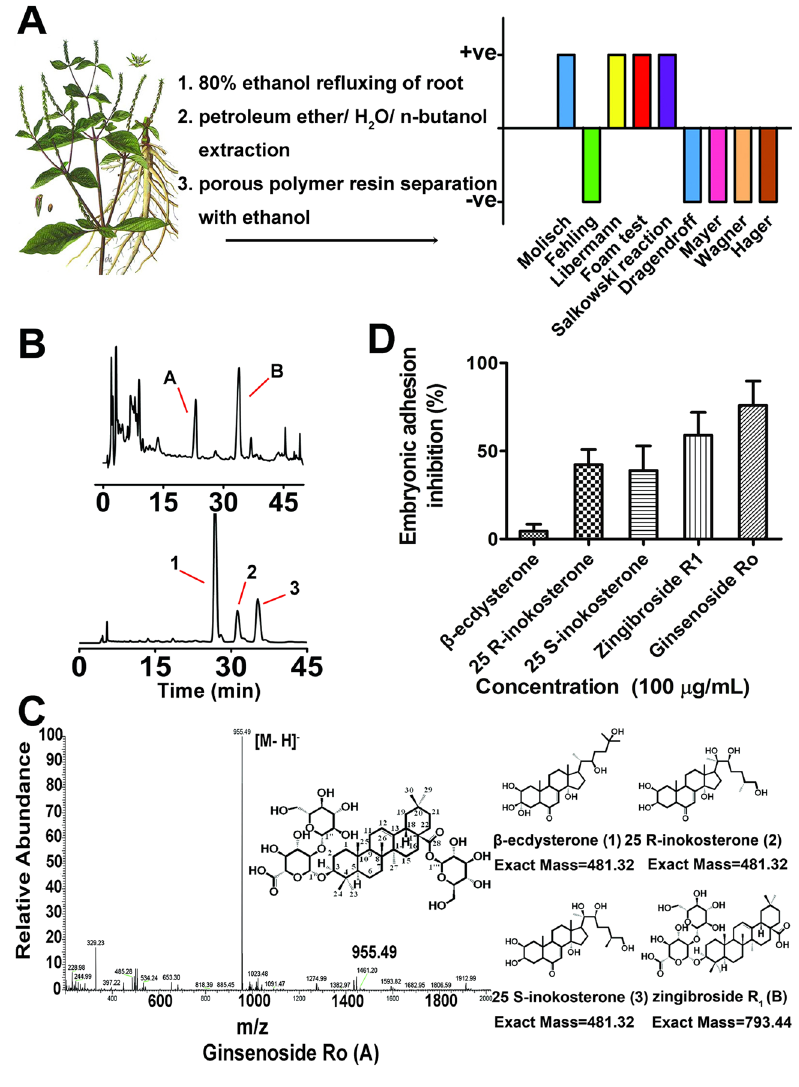
Figure 1. Phytochemical analysis and embryonic implantation comparison of five main components separated from A. bidentata root. ( A ) The smashed herb root was refluxed with 80% ethanol, and the concentrated residual was extracted with ether/water and then butyl alcohol, followed by resin column separation. The elute fraction was subjected to the standardized phytochemical screen that showed steroids positive by Salkowski and Lieberman-Burchardt assays; carbohydrates negative by Fehling’s test; glycosides positive by Molisch’s test; saponins positive by Lieberman, and foam assays; alkaloids negative by Dragendroff, Mayer, Wagner and Hager assays. ( B ) Further fine HPLC separation showed that the elution mainly contained two saponins and three sterones. ( C ) Mass and NMR analyses suggested that they are A: ginsenoside Ro; B: zingibroside R1; 1: β -ecdysterone; 2: 25 R-inokosterone; and 3: 25 S-inokosterone. ( D ) Human embryo/ endometrium adhesion test showed that ginsenoside Ro was the most potent among the five components in inhibiting the